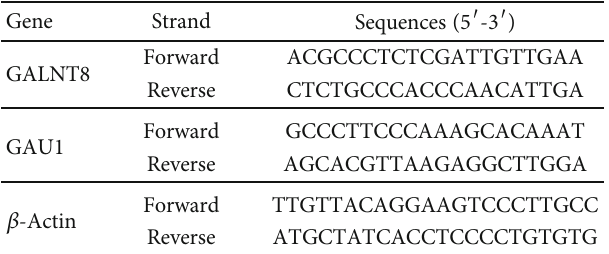
Table 1: Primer sequences for gene ampli fi cation. Gene Strand Sequences (5 ′ -3 ′